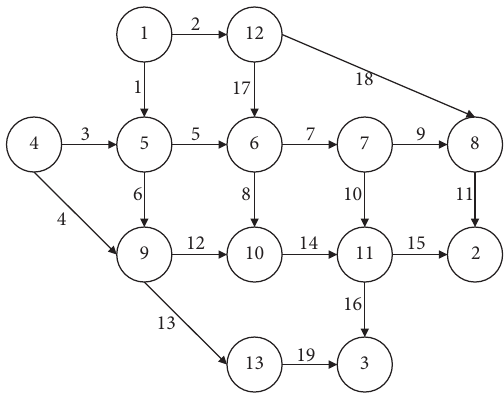
Figure 4: Nguyen-Dupuis